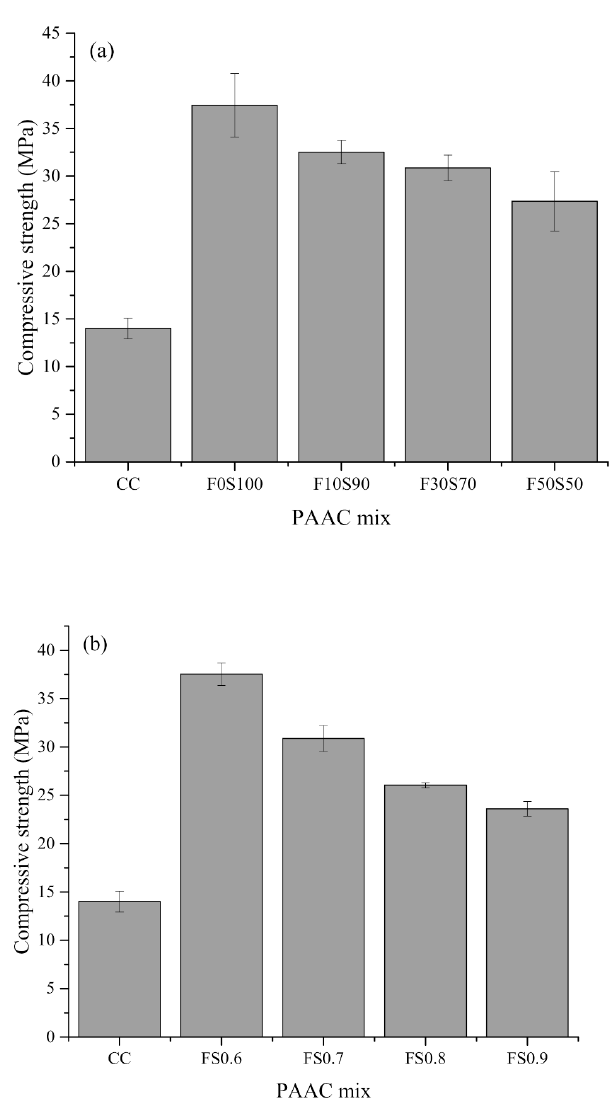
Figure 5. Compressive strength of preplaced aggregate concrete mixes: ( a ) Series 1 and ( b ) series 2. PAAC: Preplaced alkali-activated